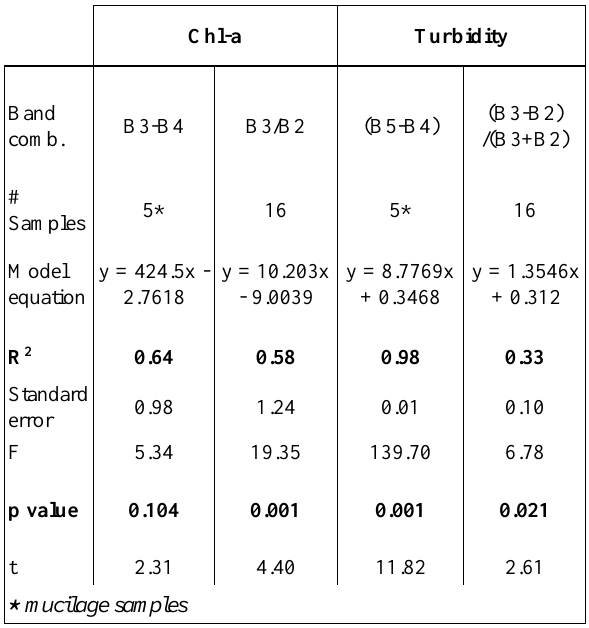
Table 3 . Statistics of the regression models selected in the preliminary analysis for 2